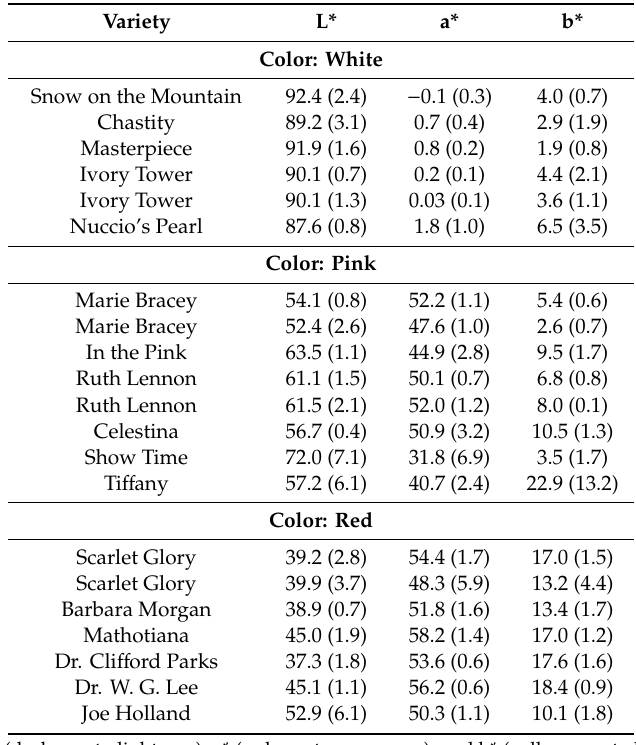
Table 5. Mean (standard deviation) of the Nix TM Pro color sensor readings from three petals from the same camellia plant for each plant sampled.